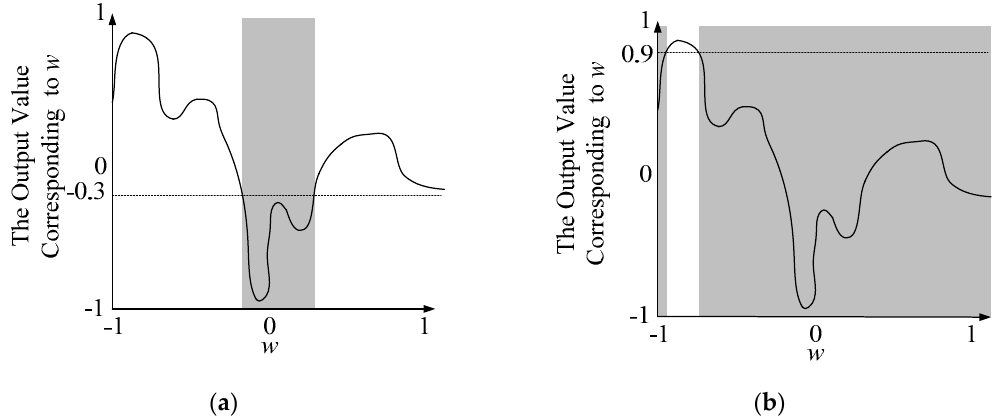
Figure 8. Graphs explain the operational range of weights in a neural network: ( a ) operational range resulting from general normalization; ( b ) operational range resulting from the usual case emphasizing normalization method (UCENormalization).